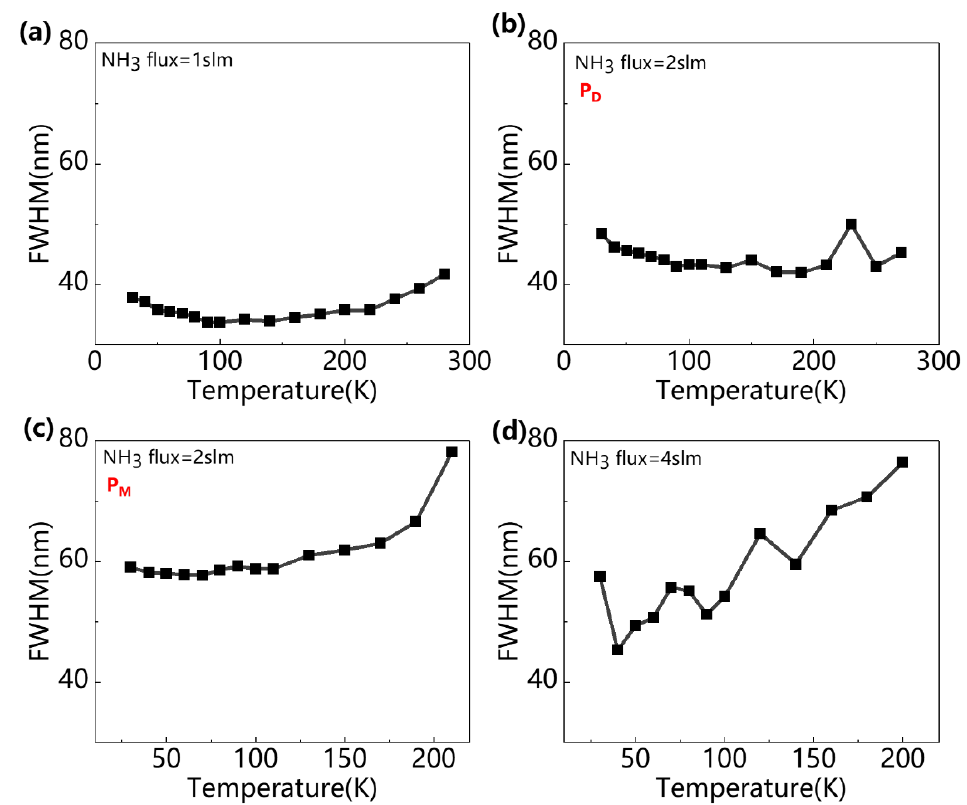
Figure 4. Temperature ‐ dependent full width at half magnitude (FWHM) of PL peaks for samples A, B, and D in series II ( a – d ) grown with NH 3 flux of 1, 2, and 4 slm, respectively, where PD is marked for the peak from QD ‐ like centers and PM is marked for the peak from quantum wells ( b , c ). The connected lines are only used for visual purposes.